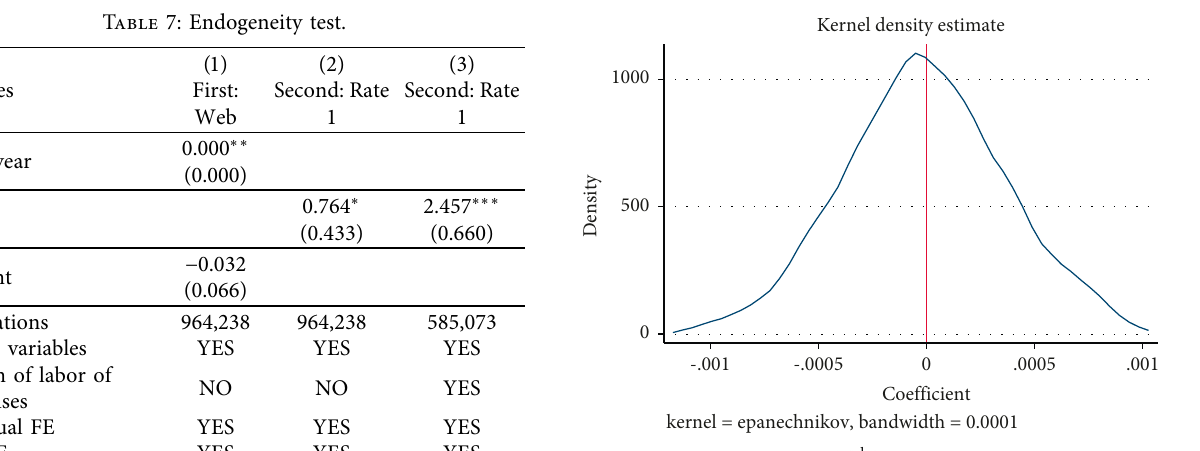
after randomization (placebo